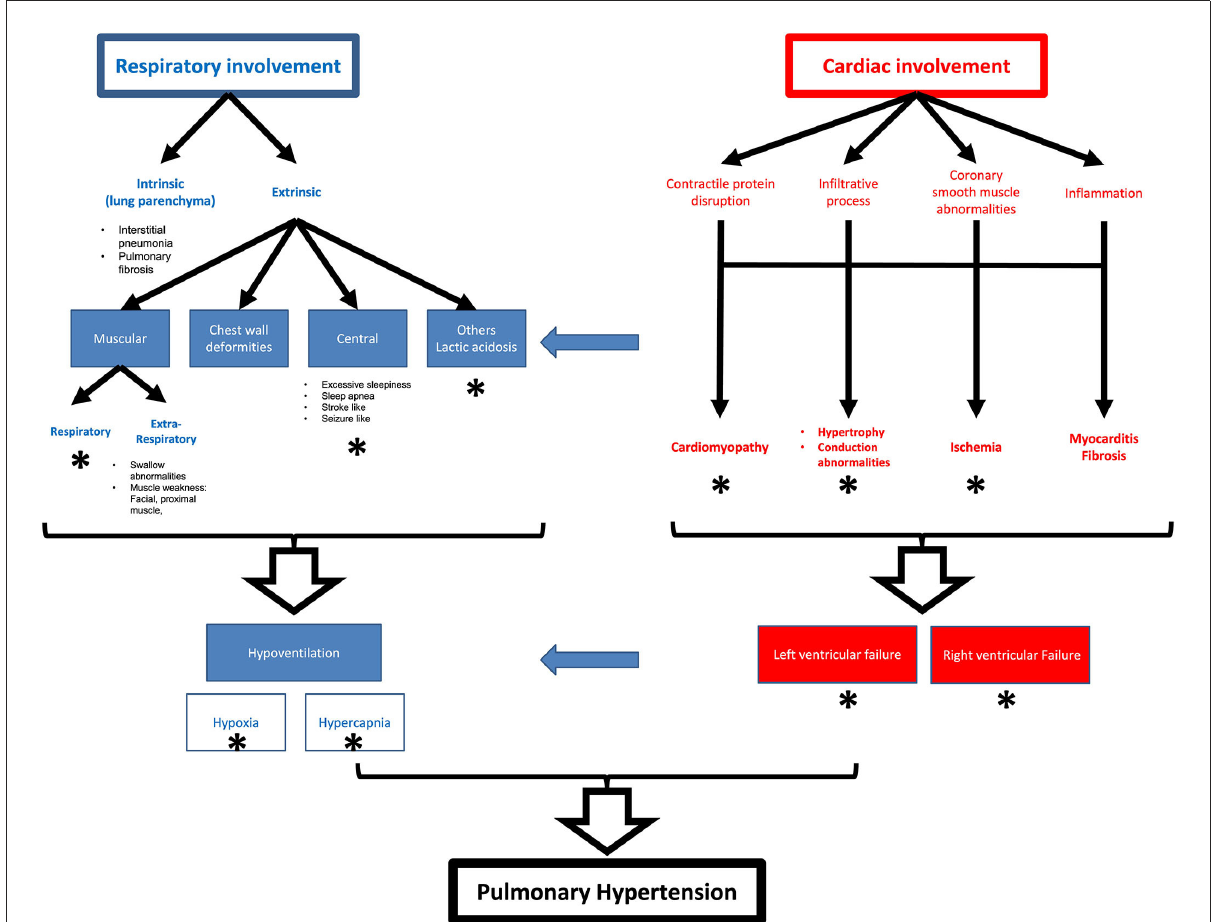
FIGURE2 Schematic representation of pulmonary and cardiac effects in myopathies and their relationships. Star represent mechanisms reported for nemaline